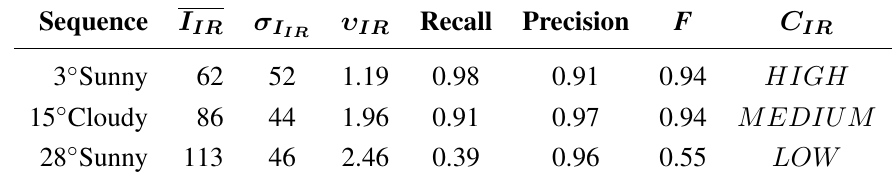
Table 2. Confidence values C to HIGH .